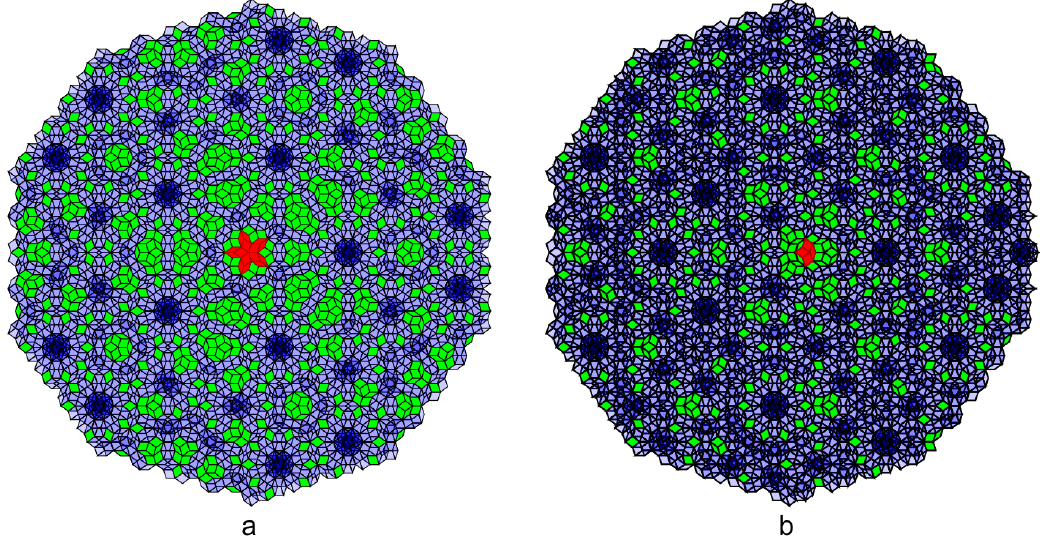
Figure 13. Results of the empire calculation for two different local vertex types in Penrose tiling, using the cut-and-project method; ( a ) shows the empire of the vertex type S5 and ( b ) shows the empire of the vertex type K. The green tiles are the forced tiles (empire) by the local vertex configuration (red), while the gray superimposed tiles are not forced. Notice that the gray tiles are projection of faces of full cubes from Z5 and they form networks of these projected cubic